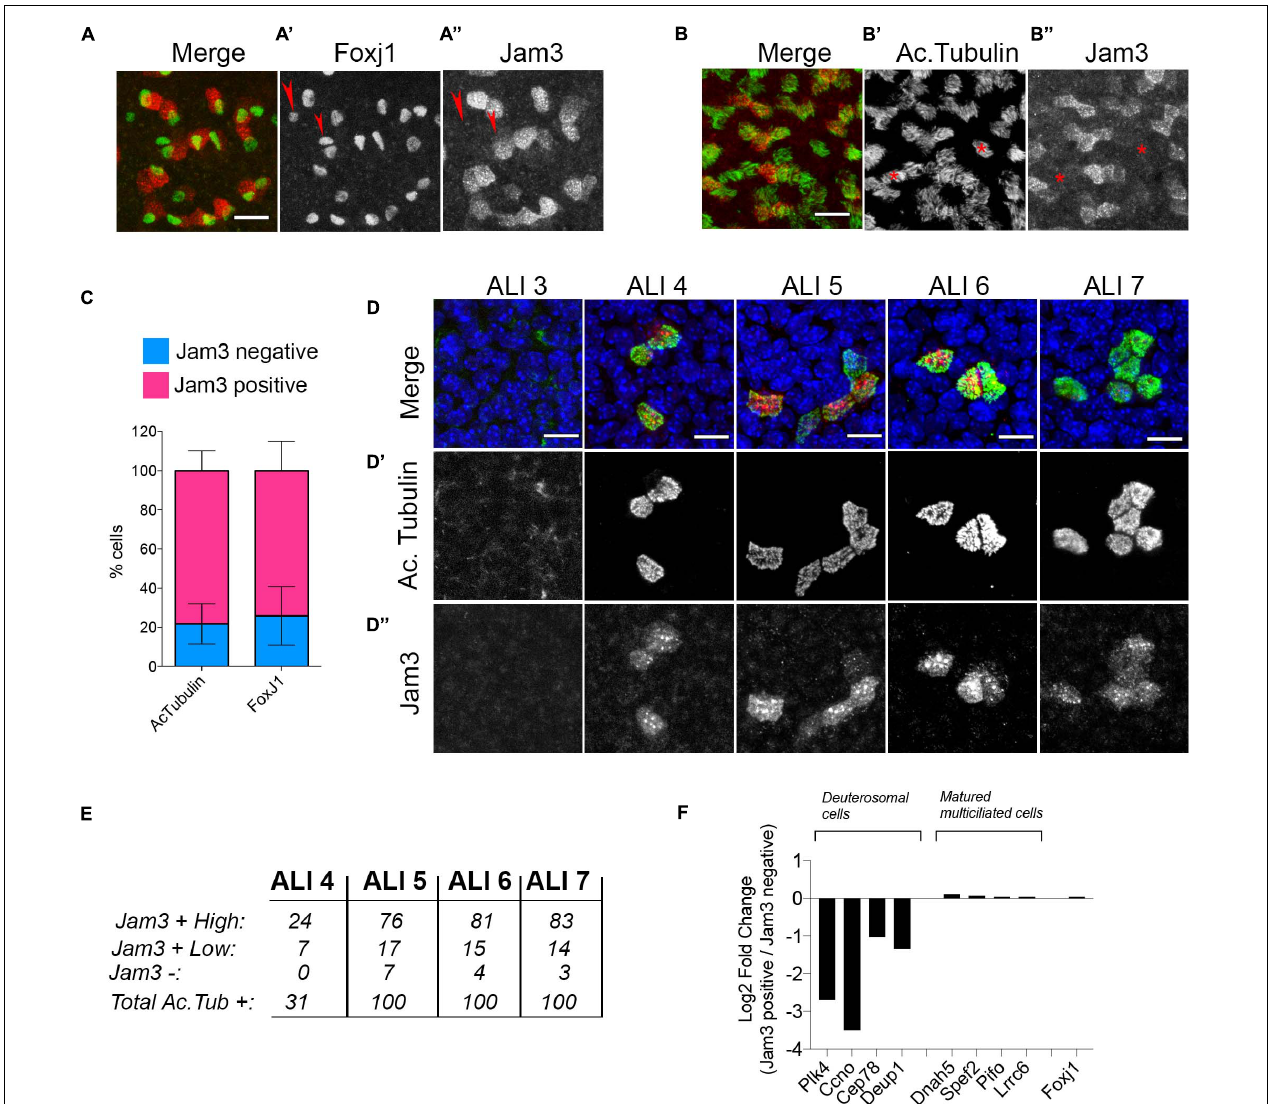
FIGURE 2 | Junctional adhesion molecule 3 (Jam3) expression is restricted to a subset of multiciliated cells. (A,B) Representative images for Jam3 and Foxj1 (A) or acetylated tubulin (B) to evaluate the co-labeling of MCCs. Foxj1 in green (gray in panel A’ ), and Jam3 in red (gray in panel A” ) Acetylated tubulin in green (gray in panel B’ ), and Jam3 in red (gray in panel B” ) (C) Quantification of the number of cells that express Jam3 and acetylated tubulin or Jam3 and Foxj1. (D) Set of confocal images at different days of differentiation (from ALI 3 to ALI7) for Jam3 in red (gray in panel D” ), acetylated tubulin in green (gray in panel D’ ), and nuclei in blue. (E) Quantification of acetylated tubulin-positive cells with high levels of Jam3, low levels of Jam3, or negative for Jam3 from ALI4 to ALI7. No acetylated tubulin or Jam3-positive cells were detected in ALI3. (F) Relative gene expression levels for deuterosomal cells and mature ciliated cell markers in Jam3-positive or negative cells (all of them are Foxj1-positive cells). Scale bar in panels (A,B) represents 20 and 10 µ m in panel (D) . Red arrow pointed Foxj1 positive cells which are Jam3 negative. Red starts marked Ac-tubulin positive cells which are Jam3